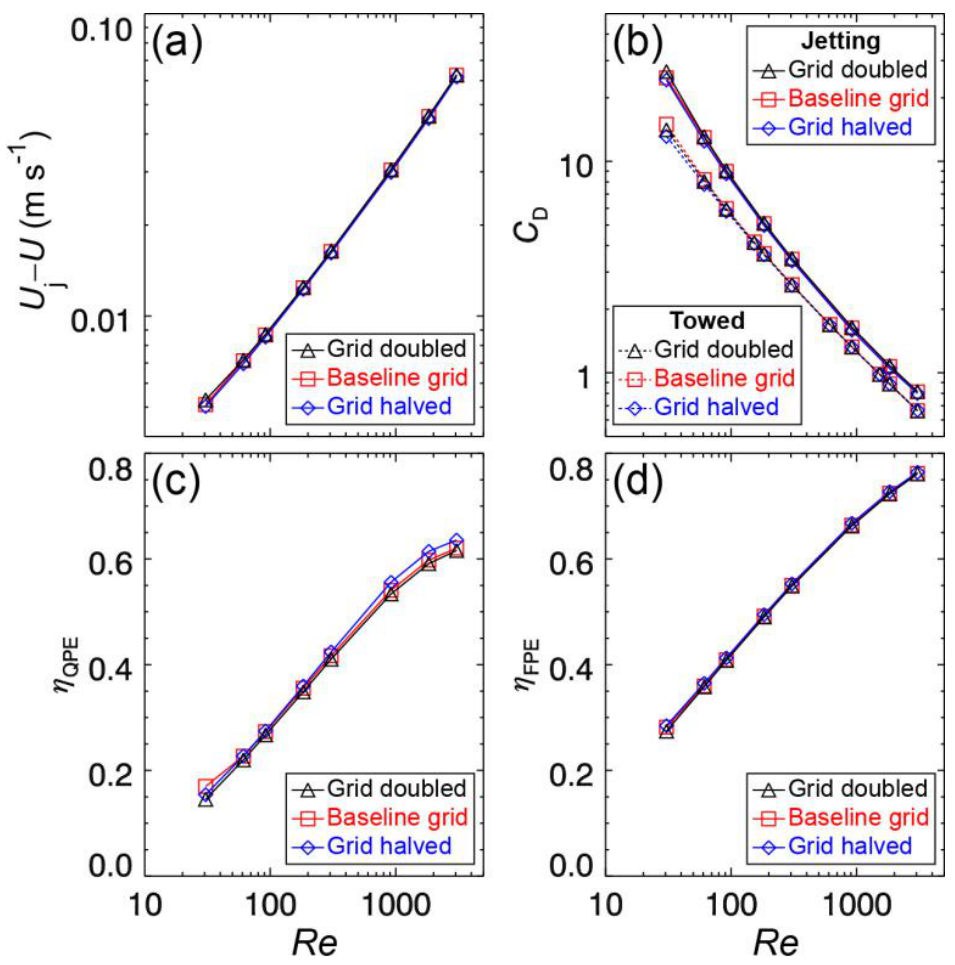
Figure 3. Results of grid refinement simulations of the jet-propelled body R6-M2 and the towed body T6: ( a ) velocity increment, U j – U , in the jet, ( b ) drag coefficient C D , ( c ) quasi-propulsive efficiency η QPE , and ( d ) Froude propulsion efficiency η FPE , as functions of Re .